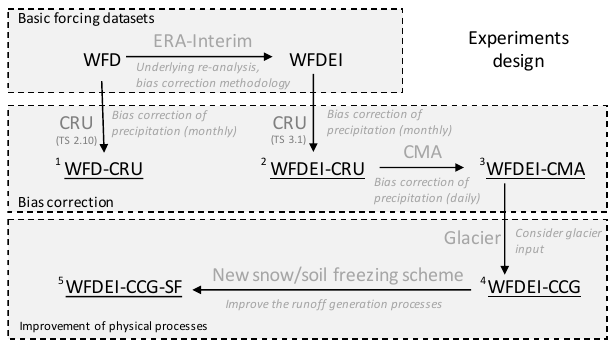
Figure 2. The flowchart of the five experiments designed for driv- ing the ORCHIDEE in this study. WFD and WFDEI are two basic forcing datasets. The underlined terms with numbers are the five ex- periments, while the grey arrows represent the development of the forcing compared to their previous